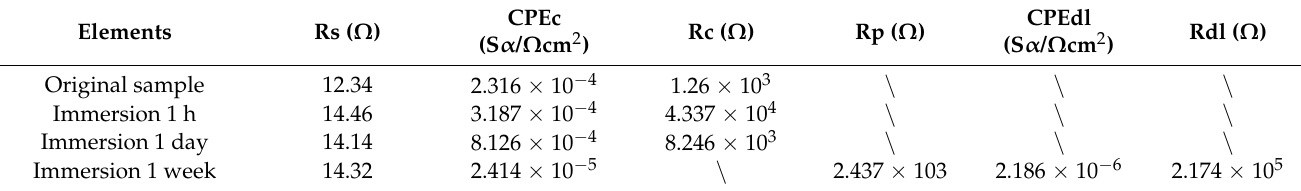
Table 3. Fitting Parameters of the Equivalent